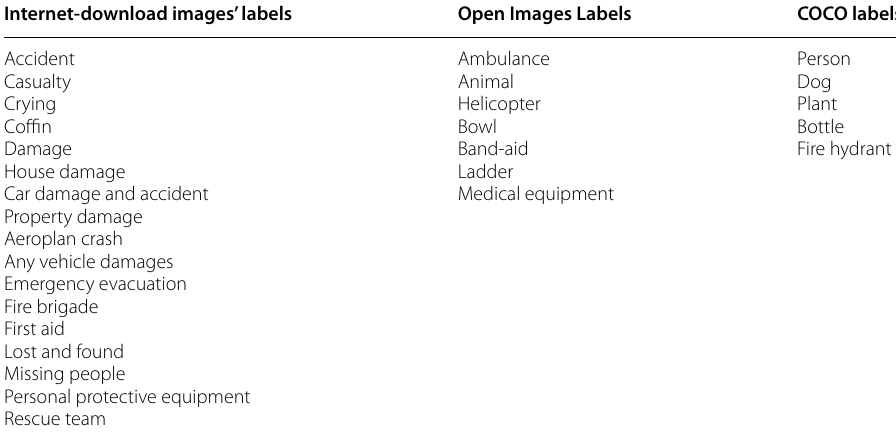
Table 5 Disaster’s labels distributions on custom and COCO